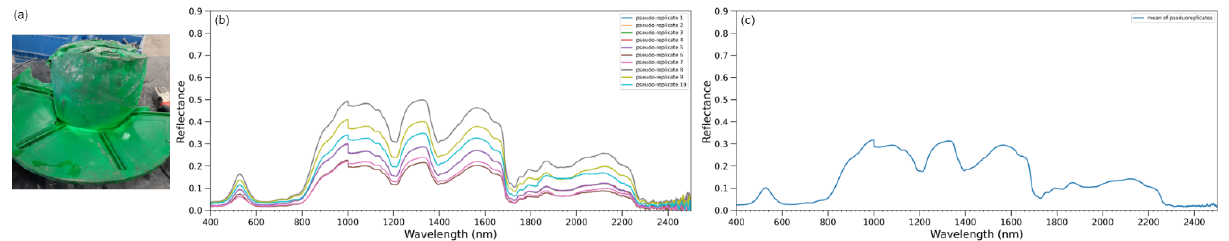
Figure 2. Experimental setup; (a) laboratory setup and (b) silo tank setup. Pictures were taken by Giulia Leone.